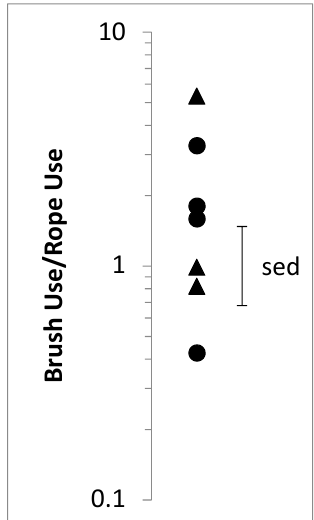
Figure 4. Brush to rope use ratio presented as a mean for 3 days (d1, d3, d6). Observations spanned from 12:00 to 08:00 the following day. The mean of each calf is represented by (female) or (male). Values are back-transformed and presented on a log transformed scale to maintain SED.